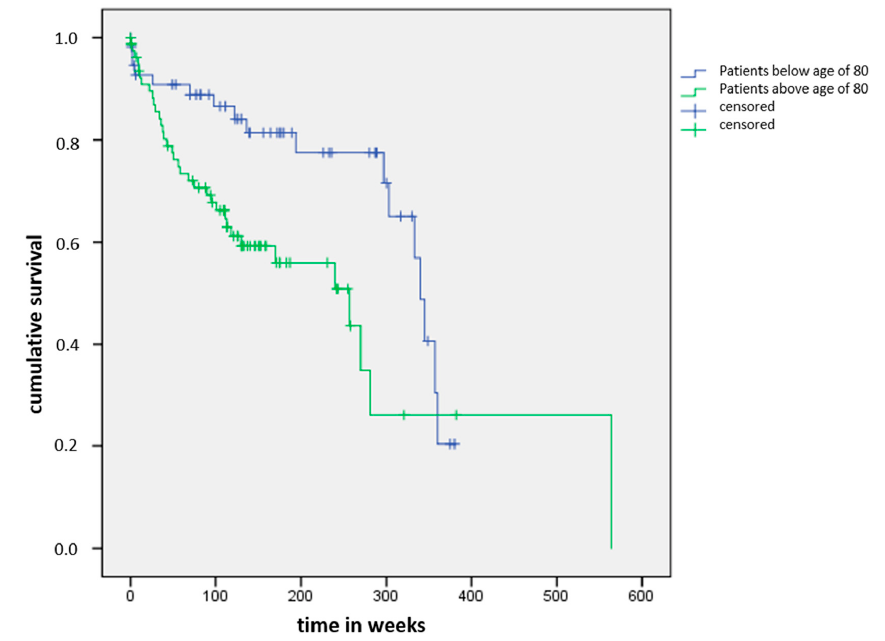
Figure 2. Kaplan–Meier curve of the cumulative survival of patient groups below and above age of 80. One-year mortality rates of reference populations and of published series of patients with FFP are listed in Table 4.